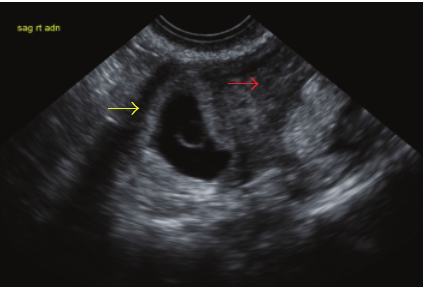
Figure 1: Transvaginal ultrasound. Red arrow: endometrial stripe of 2.4 cm and no visible intrauterine pregnancy. Yellow arrow: right adnexal mass/ectopic pregnancy.